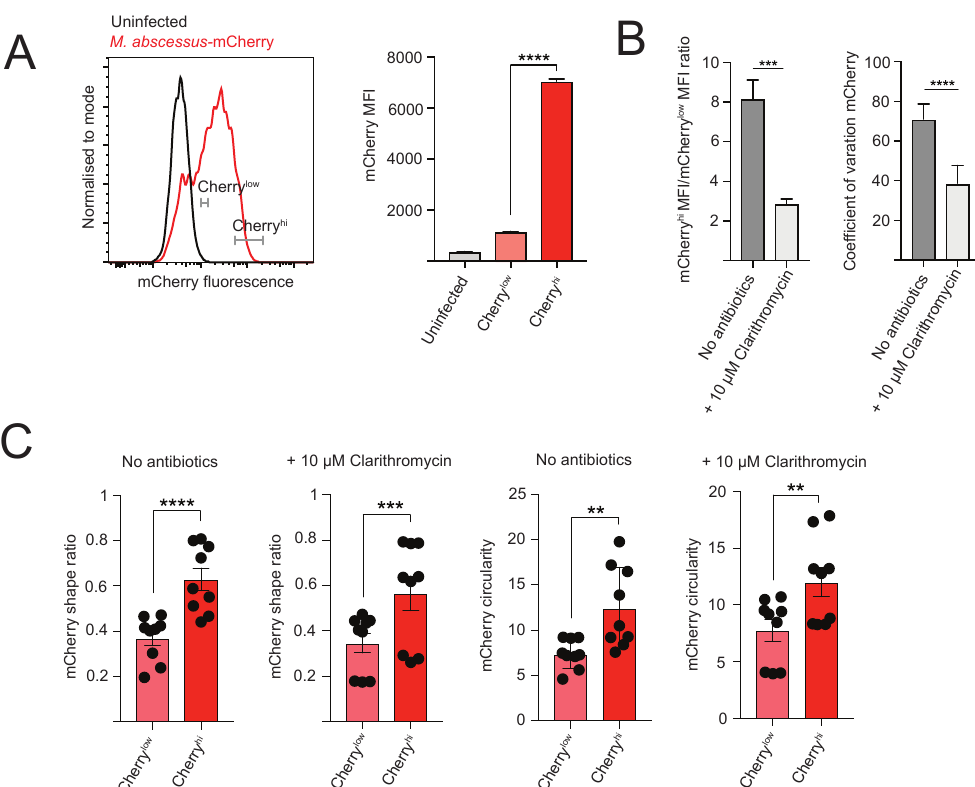
Figure 3. High variation in bacterial load in infected macrophages at single cell level. ( A ) Gating strategy used to define the 10% cells with lowest (mCherry low ) and highest (mCherry hi ) fluorescence within the mCherry + population from conventional flow cytometry data. mCherry MFI on mCherry low and mCherry hi cells. Data from 1 experiment with three technical repeats, representative of three independent experiments. ( B ) Clarithromycin treatment reduces infection heterogeneity. Fold di ff